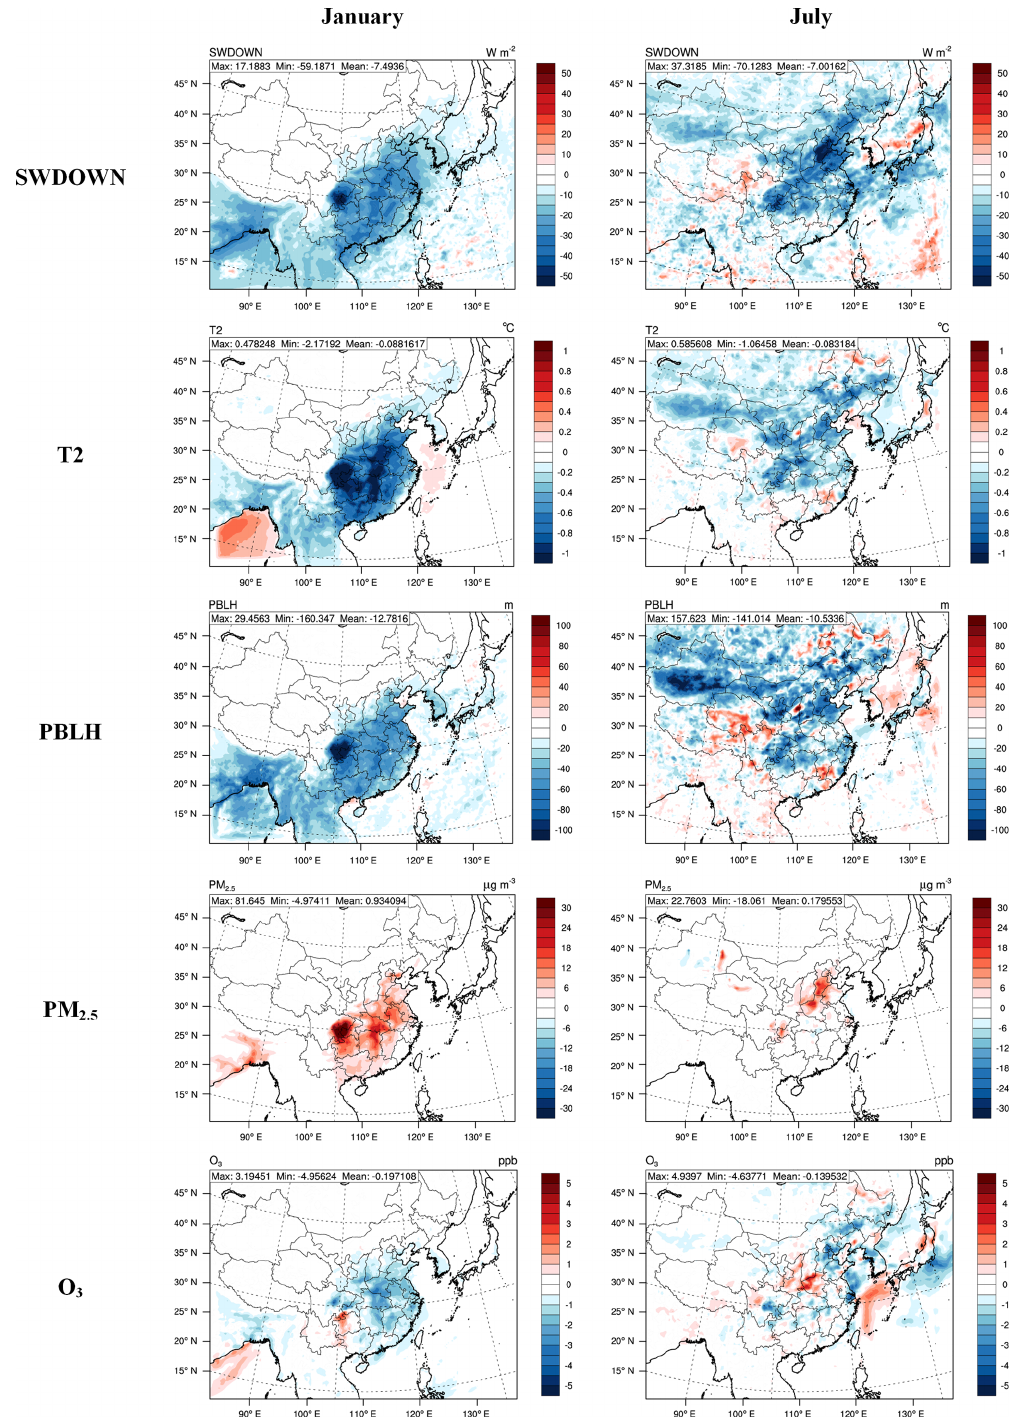
Figure 12. Effects of aerosol feedbacks on net shortwave flux at the surface (SWDOWN), T2, planetary boundary layer height (PBLH), surface PM 2 . 5 , and O 3 concentrations in January 2008 and in July 2007. The results are from the differences between the feedback and no-feedback configurations (i.e., CESM_BASE – with feedback and CESM_BASE_Sens – without feedback) of the two-way coupled WRF- CMAQ